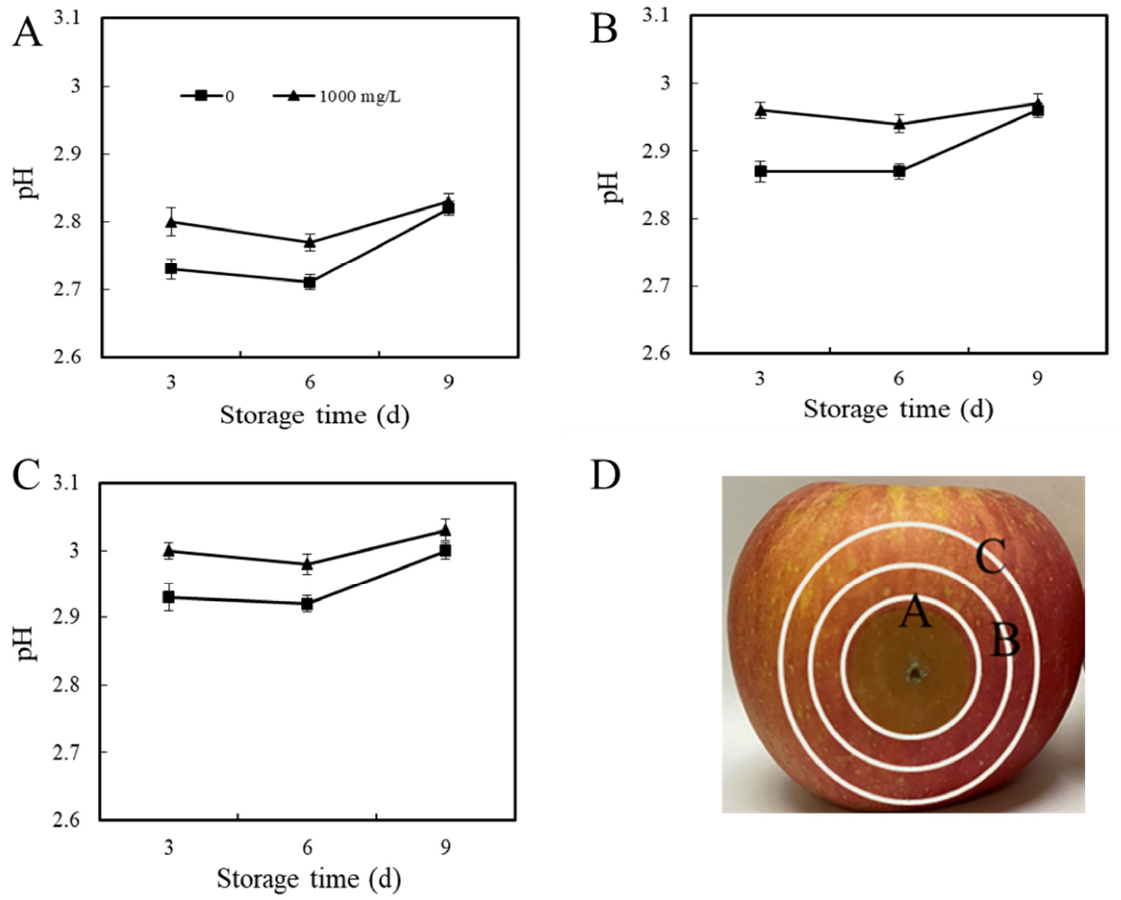
Figure 5. Effect of ε -PL treatment on pH value of different areas of the P. expansum –apple interaction. The pH of interaction area A ( A ), area B ( B ), and area C ( C ) in fruit were measured on days 3, 6, and 9 (0, 1, or 2 cm, respectively, away from the outer edge of the P. expansum –apple interaction area) with the three interaction areas shown in ( D ). The vertical bar represents the standard deviation (n = 3). Different letters indicate significant different according to Tukey’s test ( p < 0.05).